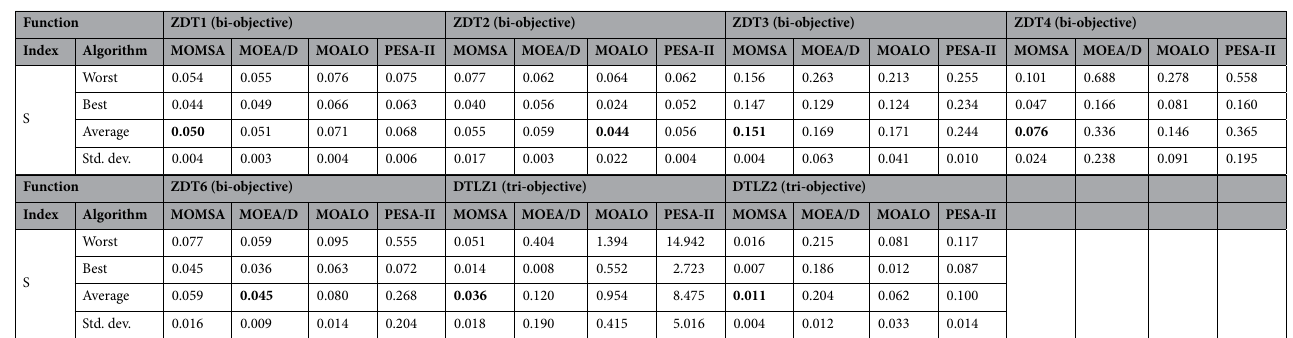
Table 6. Statistical results for S evaluation metrics on ZDT bi-objective and DTLZ tri-objective test function suite. The bold values in the table represnt the best values obtained by the utilized algorithms for each benchmark function.